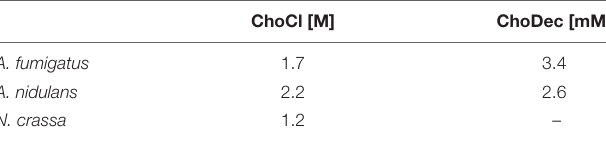
TABLE 1 | Minimal inhibitory concentrations of the cholinium-based ionic liquids (choline chloride, ChoCl and choline decanoate, ChoDec) used as media supplements for each fungal